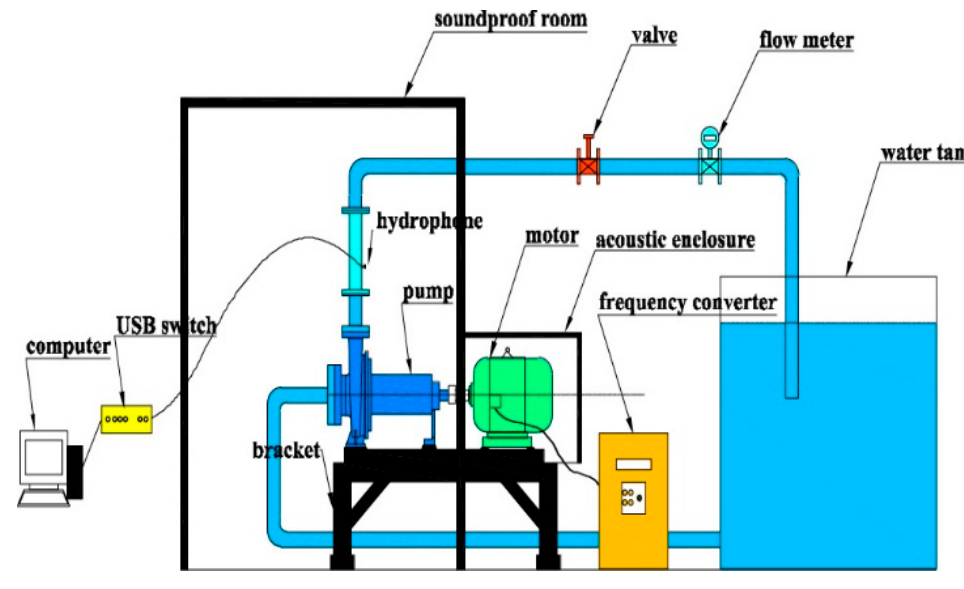
Figure 4. Test loop diagram.